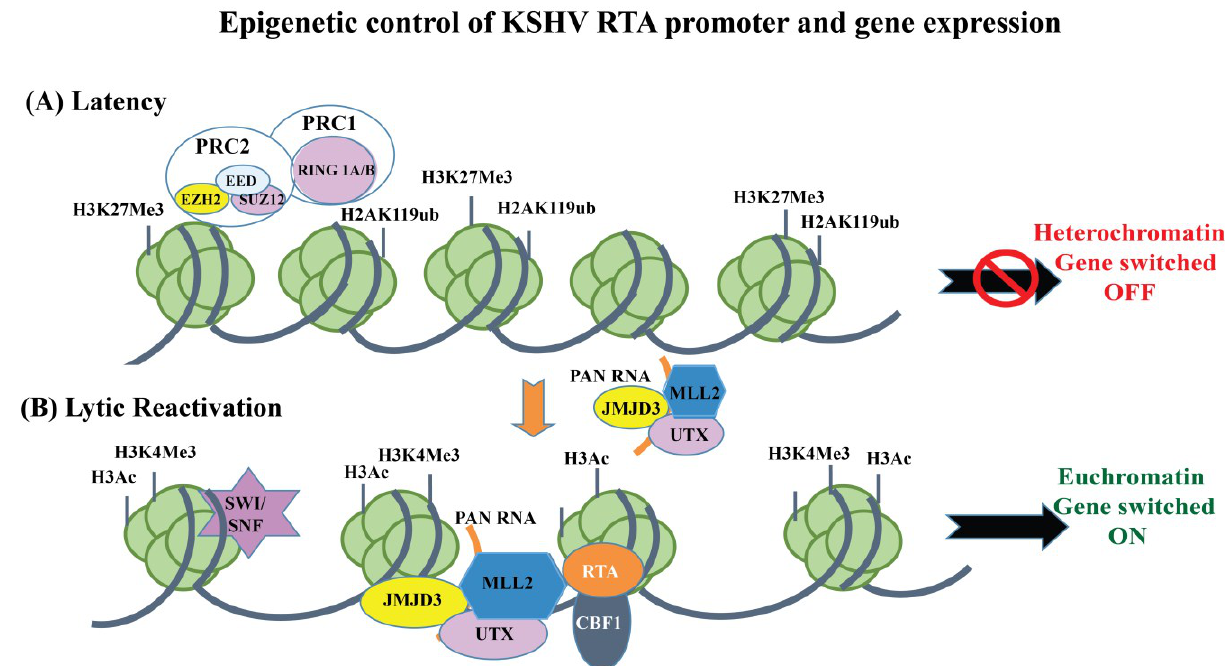
Figure 3. Polycomb repressive complexes ( PRC1 and PRC2) and Polyadenylated RNA-mediated control of KSHV RTA promoter during latency and lytic reactivation. ( A ) During latency,